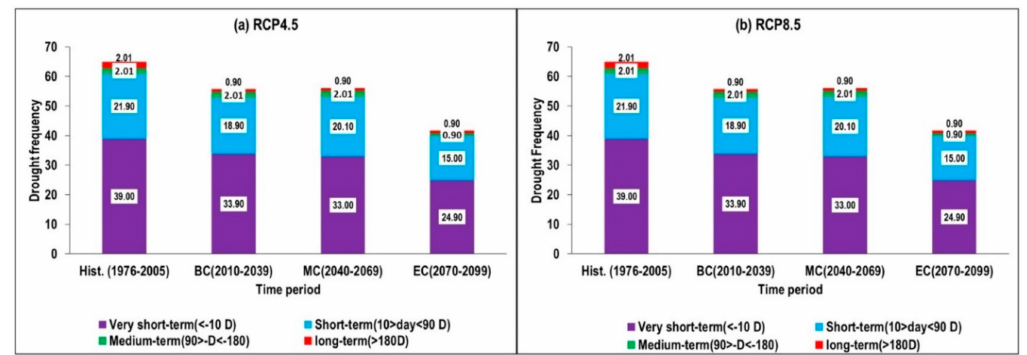
Figure 9. Change in the drought duration based on a historical period (1976–2005) in regard to long-term, medium-term, short-term, and very short-term drought events under the ( a ) RCP4.5 (left) and ( b ) RCP8.5 (right) scenarios.